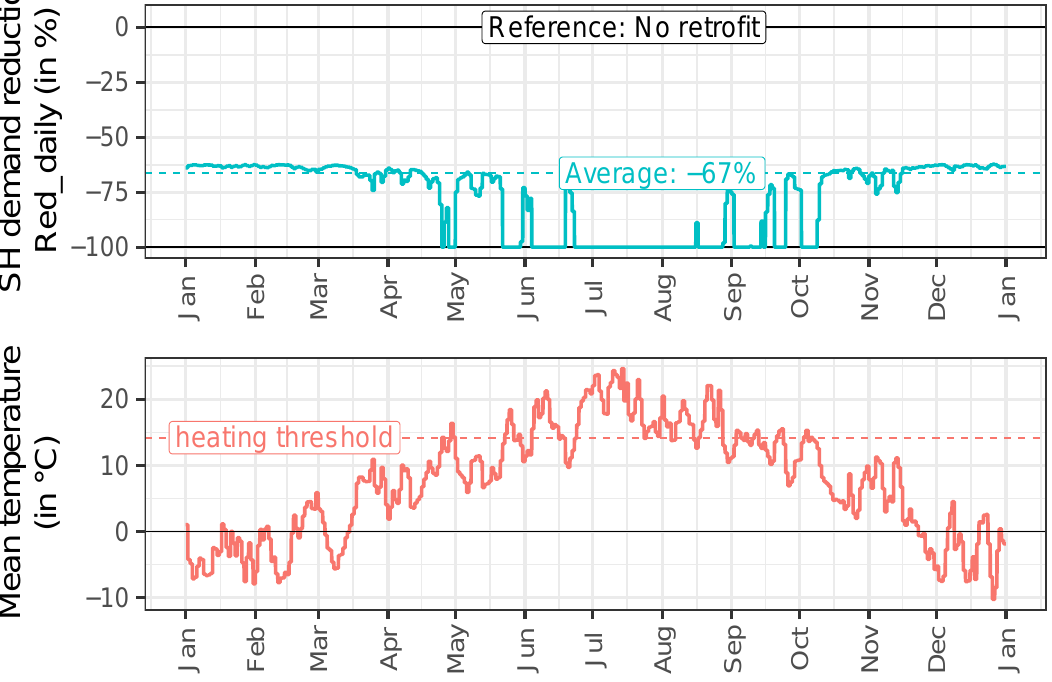
Figure 6. ( Top ): Daily space heating (SH) demand reduction Red daily calculated according to Equation (3) and the CESAR simulation in Figure 5. ( Bottom ): Corresponding daily mean ambient temperature T daily in the CESAR